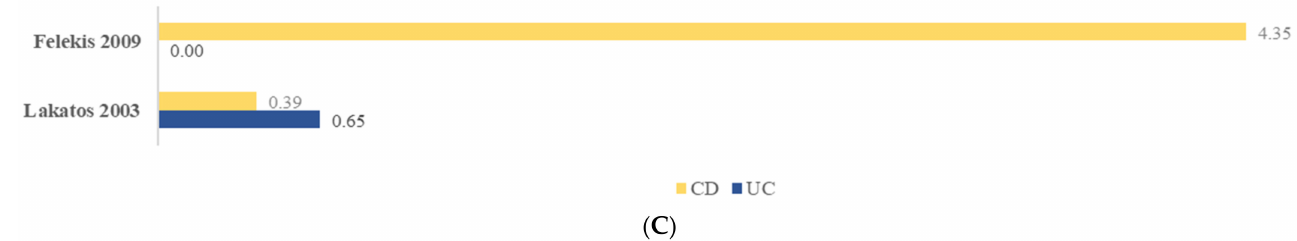
Figure 5. Period prevalence (%) of ocular manifestation among adult patients with inflammatory bowel disease: ( A ) uveitis; ( B ) episcleritis; ( C ) conjunctivitis. CD, Crohn’s disease; UC, ulcerative